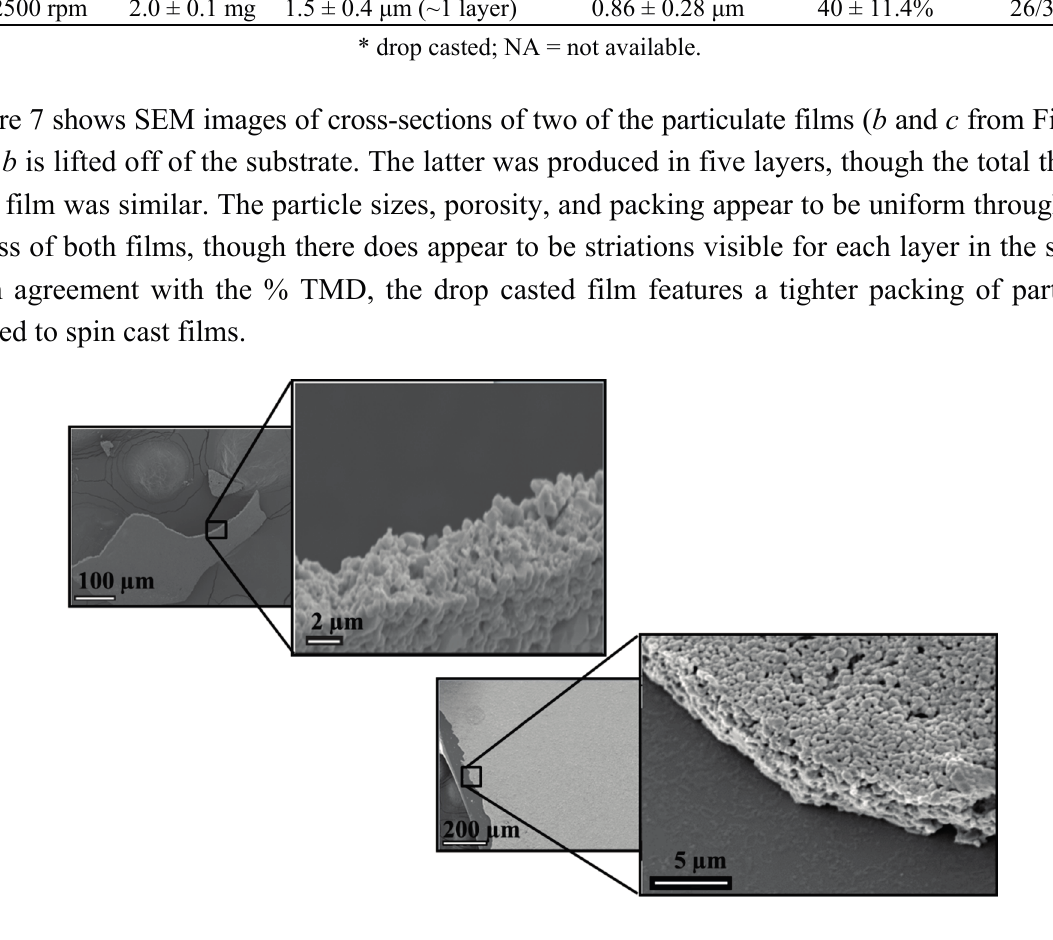
Figure 7. ( Top , left ) SEM image of a fragment from a drop-casted film. ( bottom , right ) spin coated film deposited at a rate of 500 rpm with five coatings. Films were casted from a HI 3 O 8 suspension sonicated in denatured ethanol and deposited at ~2% relative